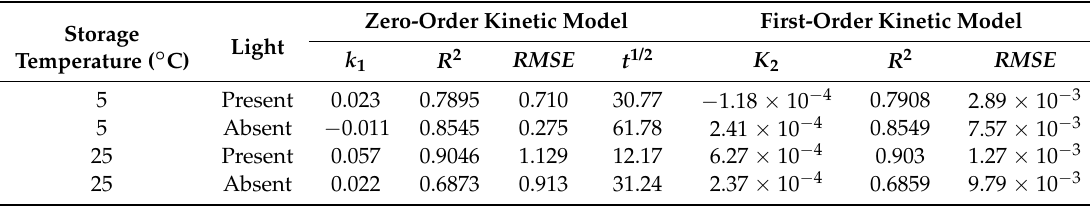
Table 8. Kinetic parameters of zero-order and first-order